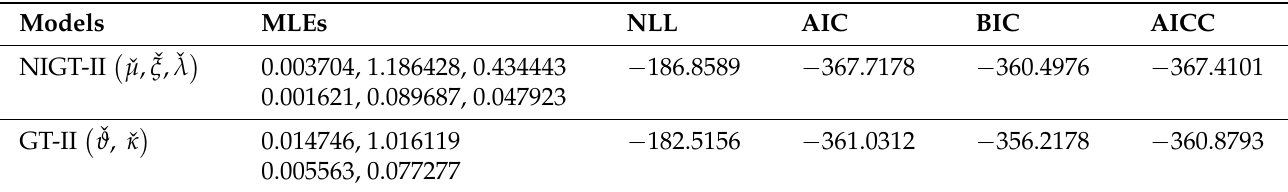
Table 4. Statistical outcomes of NIGT-II and GT-II models for the first data.